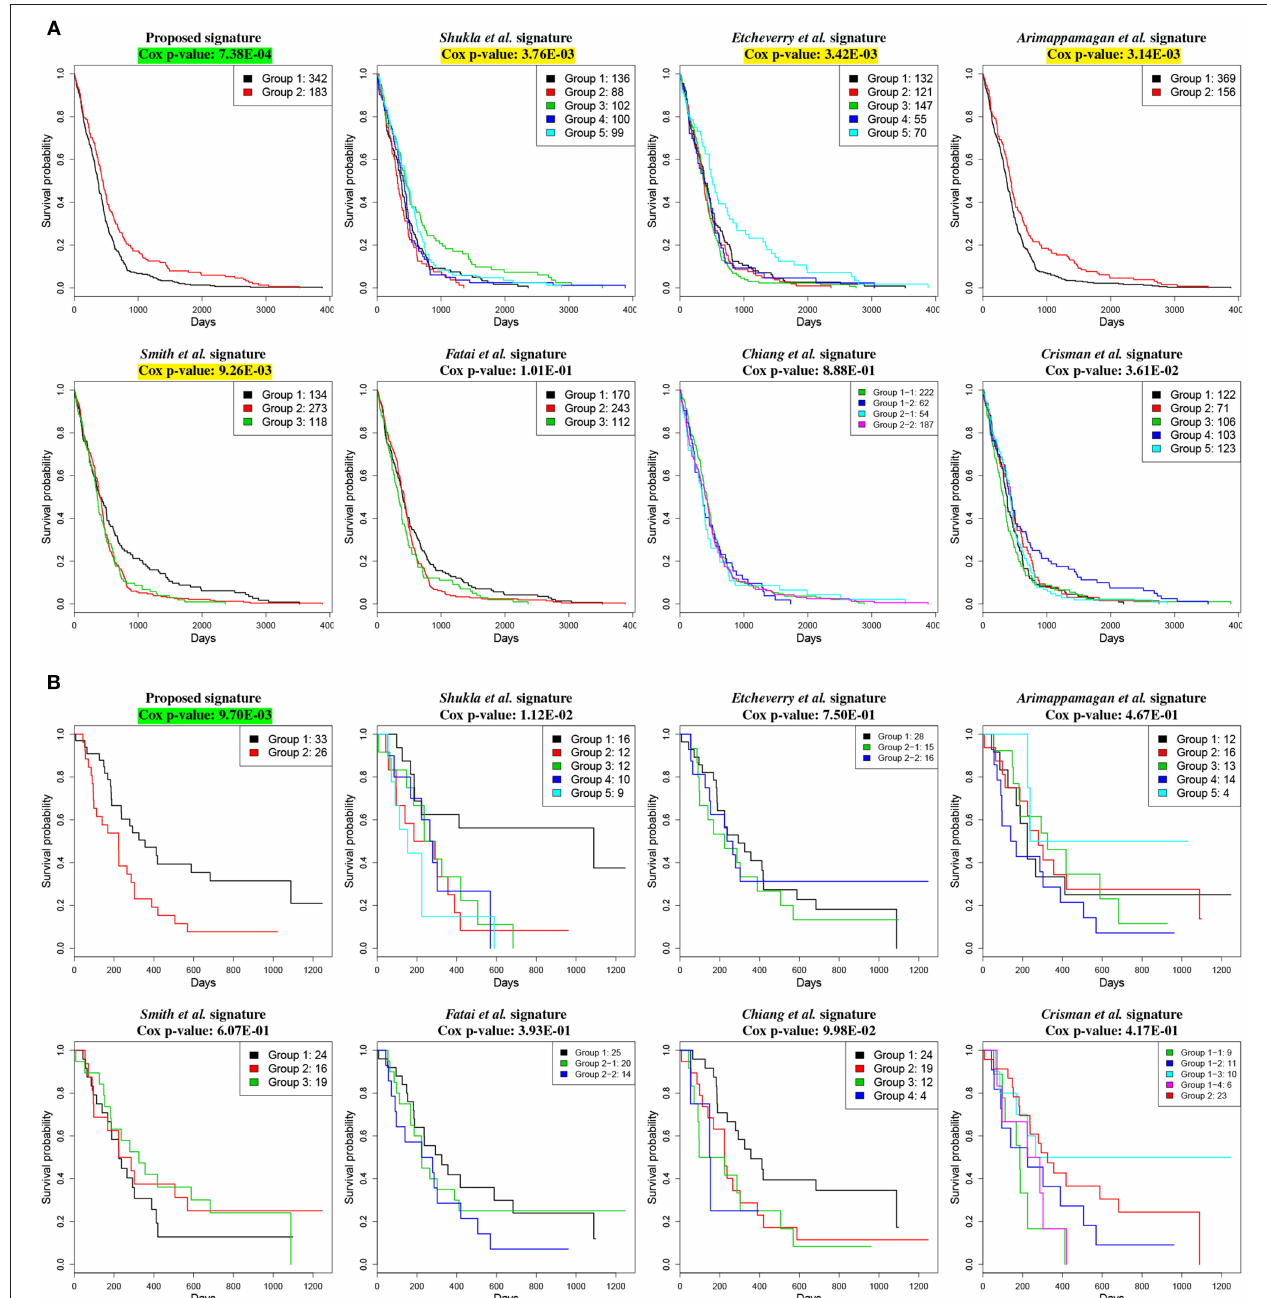
FIGURE 3 | Kaplan–Meier survival analysis on GBM studies, using different gene signature panels. (A) TCGA dataset which contains gene expression profiles from 525 individual patients. (B) GSE4211 dataset which contains gene expression profiles from 59 individual patients. The horizontal axes represent the time (in days) from the start of the study, whereas the vertical axes represent estimated survival percentage. Yellow colors represent the Cox p -values that are significant ( < 0.01). The green color indicates the best signature (i.e., lowest Cox p -value) for the given dataset. These results show that the proposed signature yields the best separation between aggressive and less aggressive disease on both